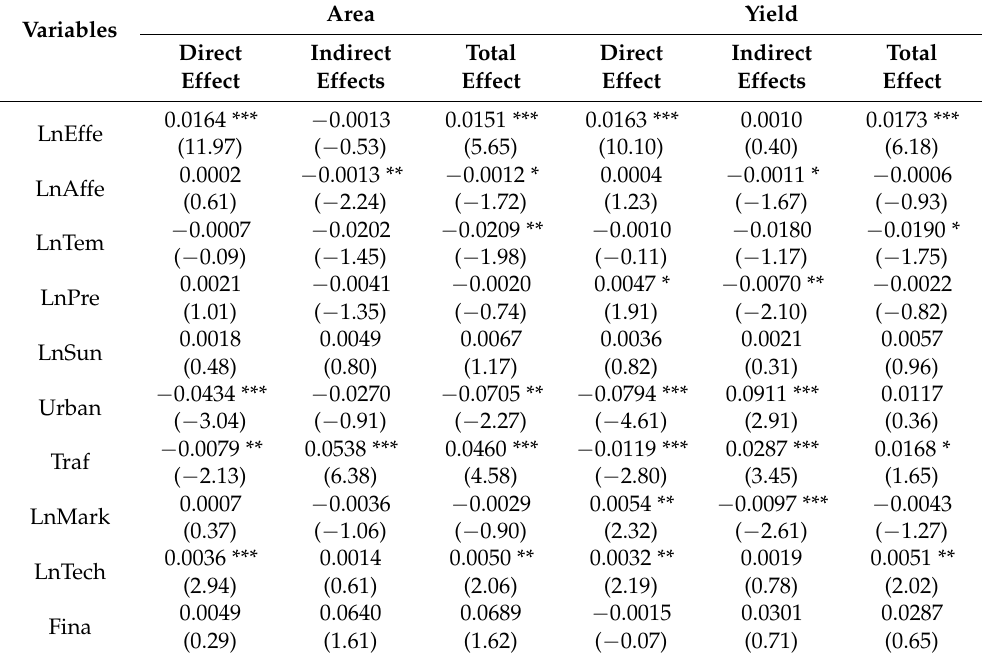
Table 6. Decomposition results of spatial